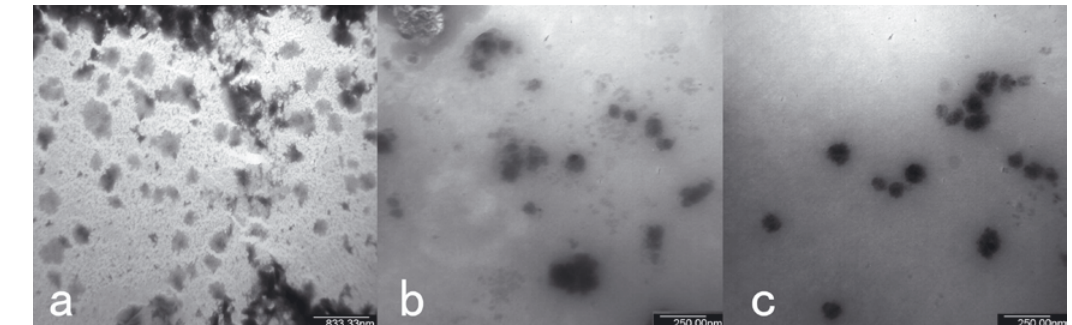
Figure 6. TEM images of polymer / DNA complexes at N/P ratio = 1:1. PDMAEMA/DNA complexes (a), P30/DNA complexes (b), P60/DNA complexes